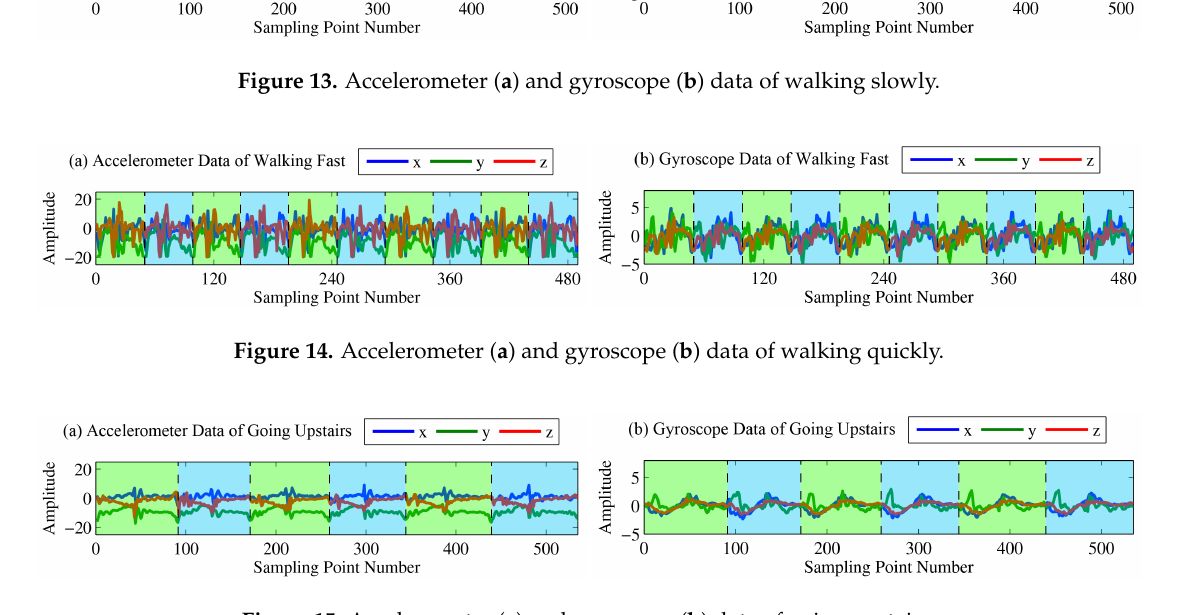
Figure 15. Accelerometer ( a ) and gyroscope ( b ) data of going upstairs.